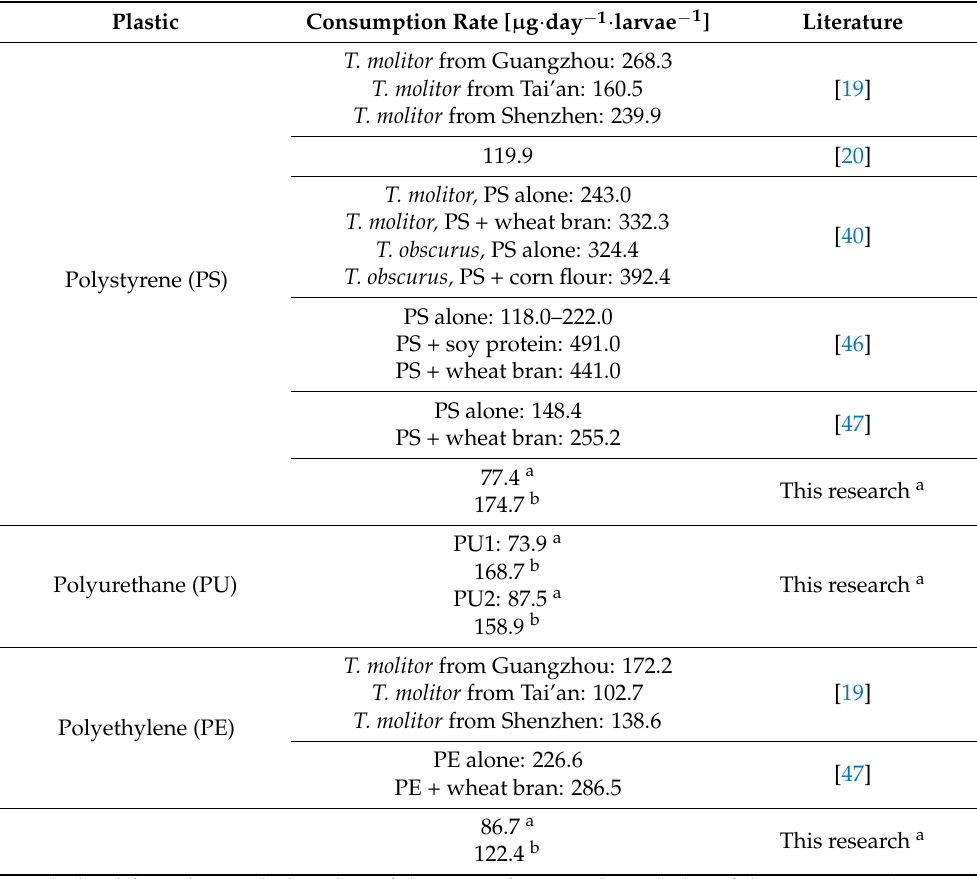
Table 4. Plastic consumption rates calculated on the basis of literature data and from this publication.